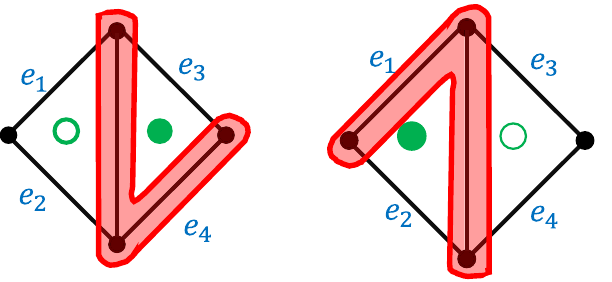
FIG. 12. Edges (highlighted in red) that can be afflicted by an error from a single fault resulting in a left or right flag. A highlighted cross edge (corresponding to a weight-two data qubit error) corresponds to X or Z data qubit errors on edges e 1 and e 2 (which is equivalent to two-data-qubit errors on edges labeled e 3 and e 4 up to a stabilizer). Edges e 4 and e 1 correspond to weight- one data qubit errors. Such edges are referred to as boomerang edges due to the shape of the highlighted area.